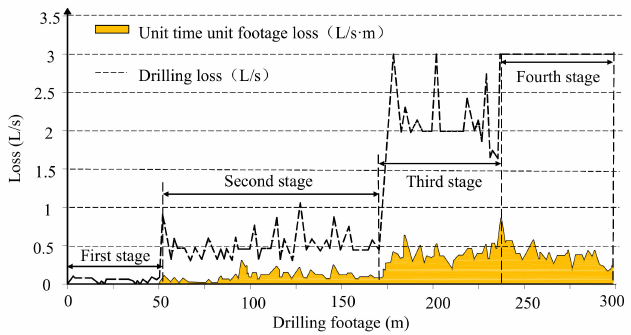
Figure 13. Variation curve of hole leakage after